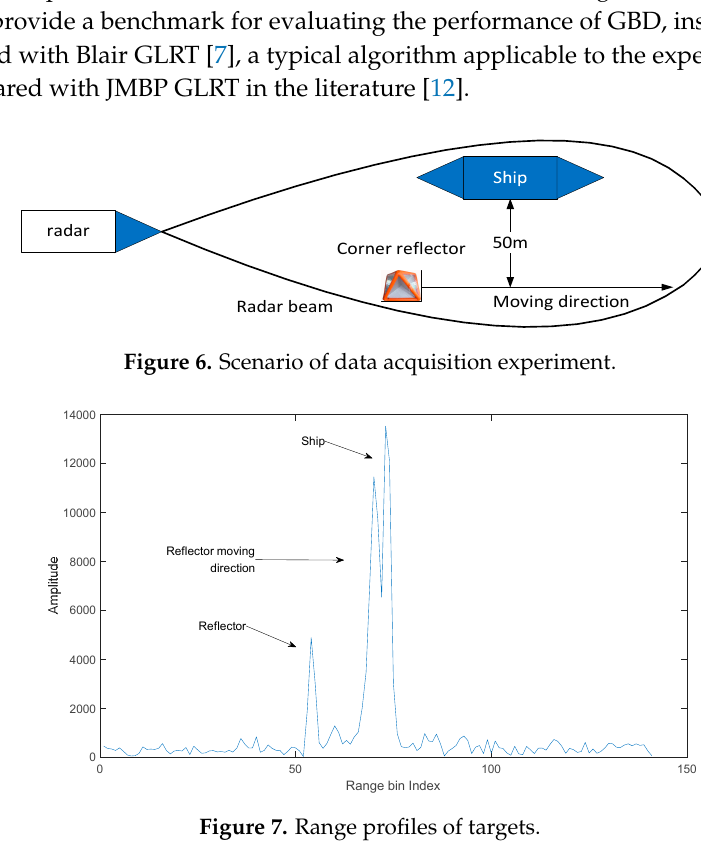
Figure 7. Range profiles of targets.